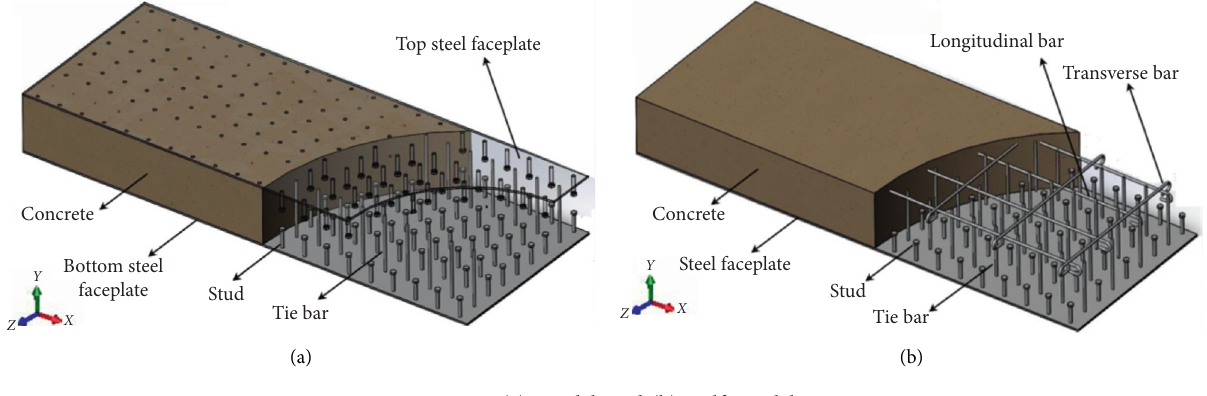
Figure 1: (a) SC slab and (b) Half-SC